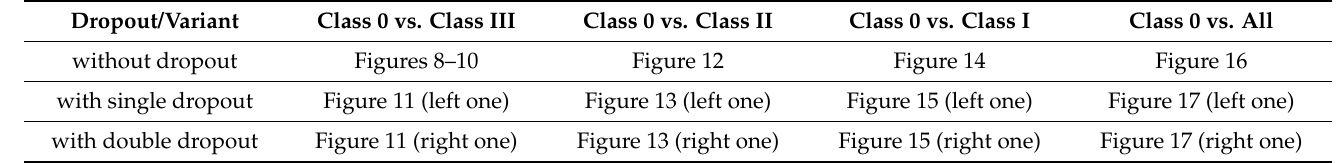
Table 2. Considered classification